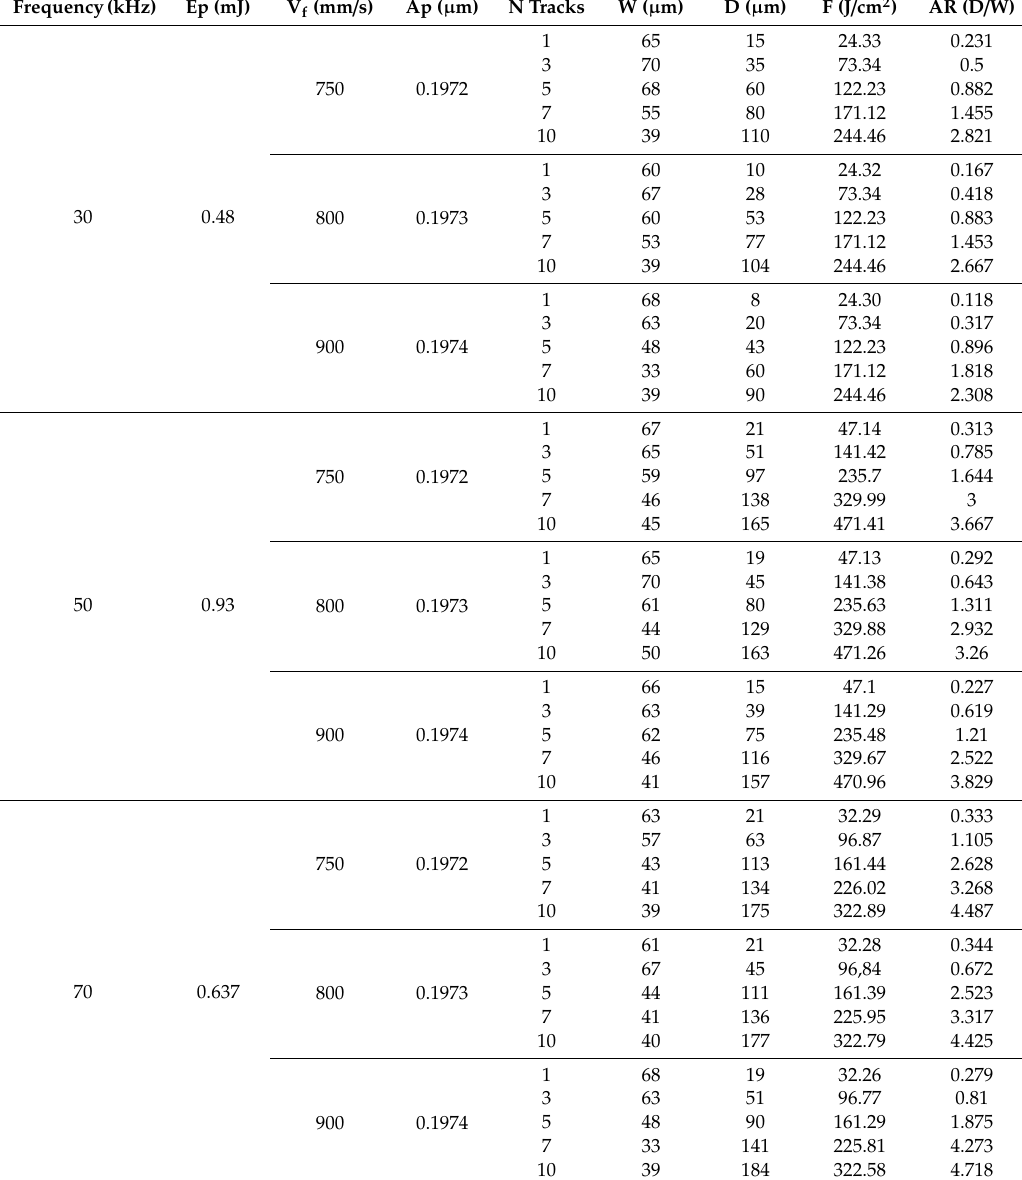
Table 4. Tested parameters for Al 7075T6. Note: D = depth of the groove; W = width of the grooves; Ep = pulse energy; V f = scanning speed of the laser beam; Ap = area swept by the beam in the 250 ns (t p ) pulse; F = creep; AR = aspect ratio between the depth and width of the